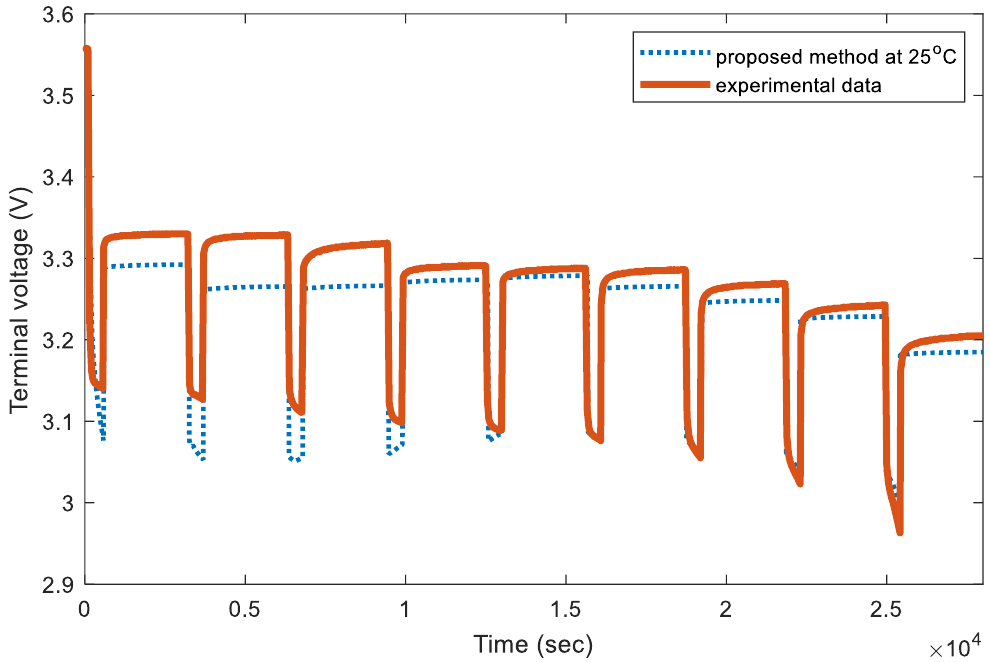
Figure 17. Terminal voltage at different ambient temperature of 25 °C.